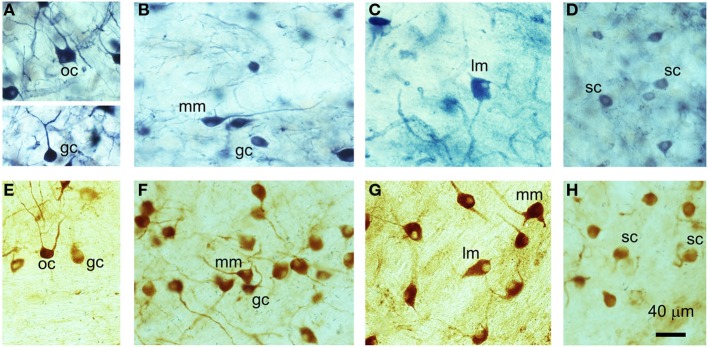
Examples of different cell types in the VCN that have been stained for NADPH-diaphorase (A–D) or nNOS immunoreactivity (E–H). (A) Globular bushy cell (GC) and octopus cell (OC), (B) medium multipolar (MM) and globular bushy cell (GC), (C) large multipolar or giant cells (LM), (D) spherical bushy cell (SC), (E) octopus cell (OC) and globular bushy cell (GC), (F) medium multipolar (MM) and globular bushy cells (GC), (G) large multipolar (LM) and medium multipolar cells (MM), (H) spherical bushy cells (SC).